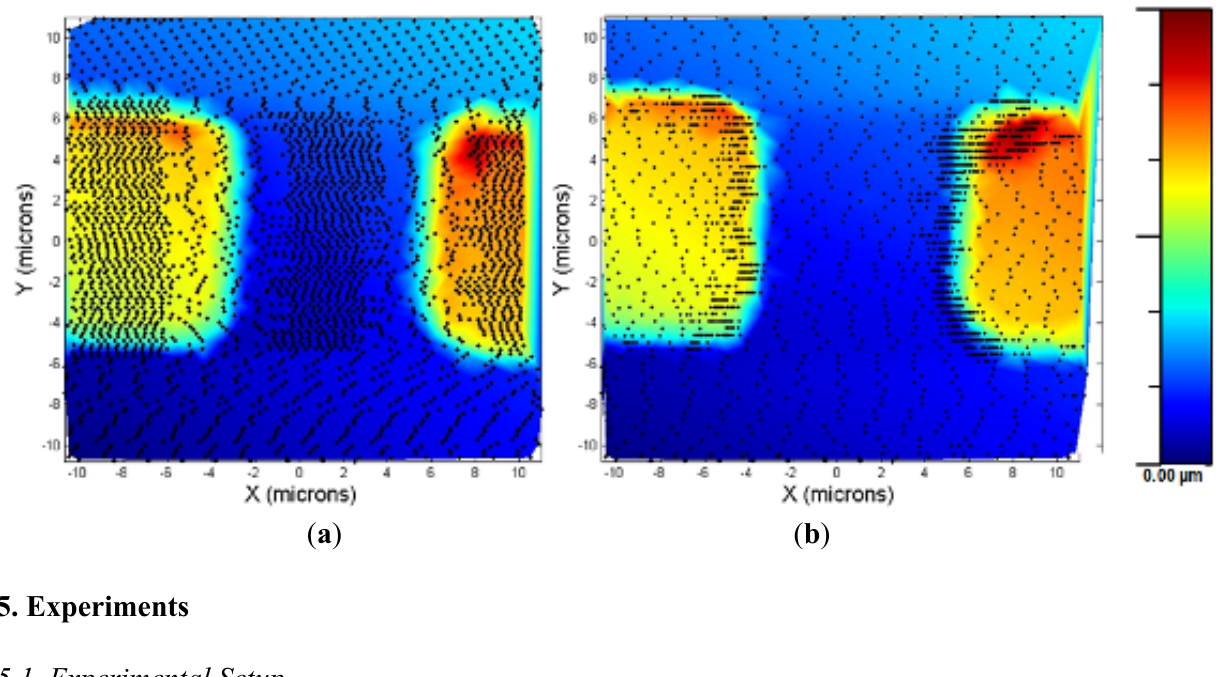
Figure 6. ( a ) Calibration grid imaged using the bang-bang controller, imaging time = 1